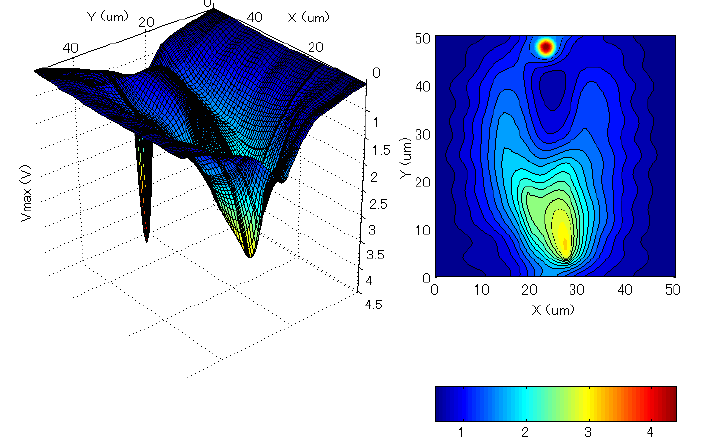
Figure 5. Potential profile in the deep part of a fundamental